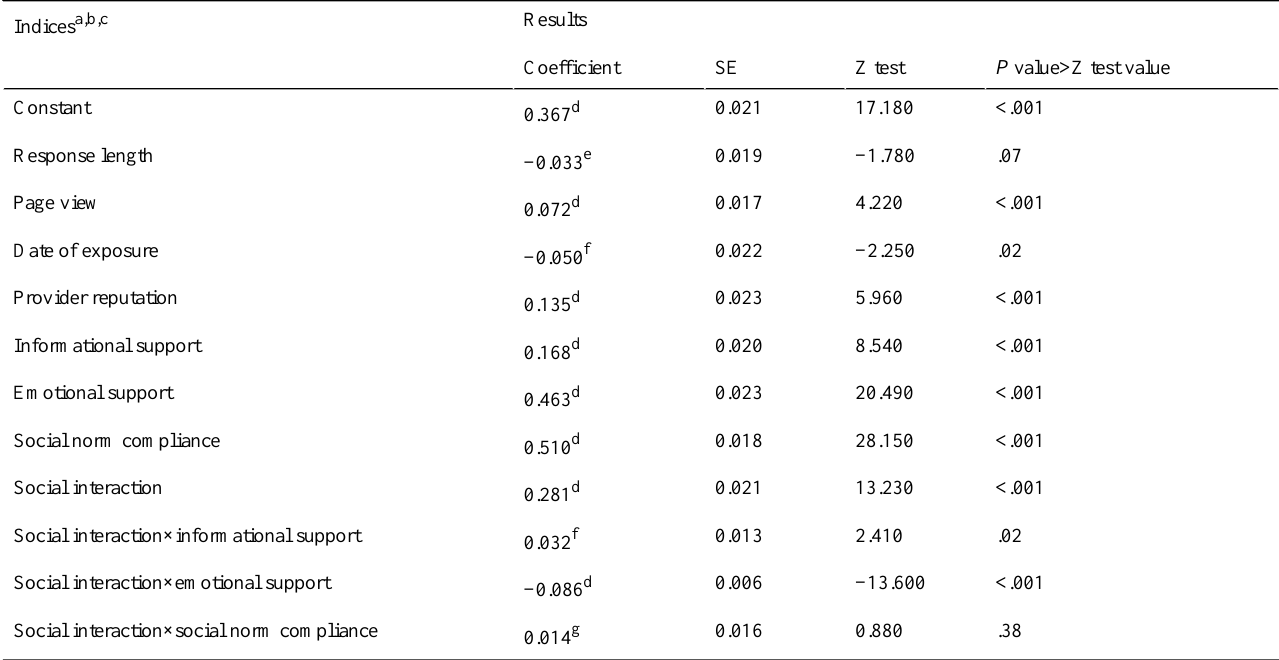
Table 4. Results of the negative binomial model